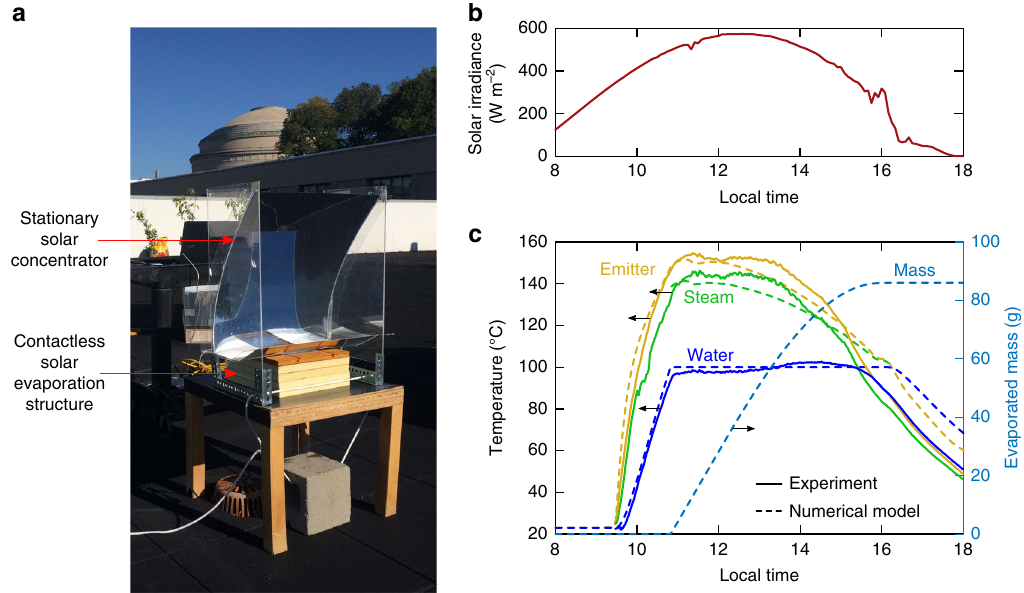
Fig. 6 Outdoor operation of the contactless solar evaporation structure. a Photograph of the outdoor experiment on the MIT roof using a stationary (non- tracking) solar concentrator. b Solar irradiance (global horizontal) measured over the course of the test day, October 21, 2017. c Performance of the CSES during the outdoor experiment. Solid lines are measured values and dashed lines are modelled values from the transient model validated vis-à-vis